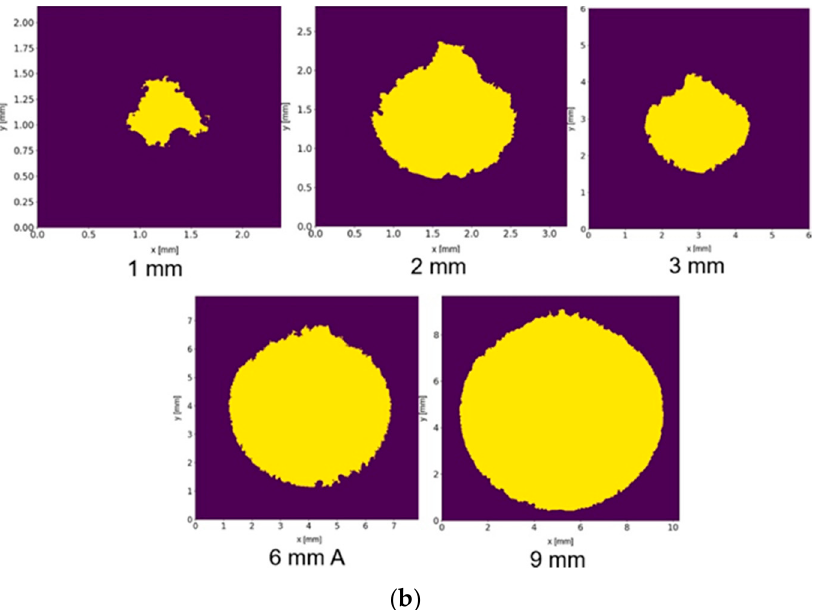
Figure 11. Difference in equivalent and nominal diameters at 4.5 mm length. ( a ) ( D eq − D nom ) for each of the investigated channels showing how the deviation from the nominal diameter is close to being constant for D nom ≥ 3 mm. ( b ) Through view of the image stacks. Notice the differently scaled axes.